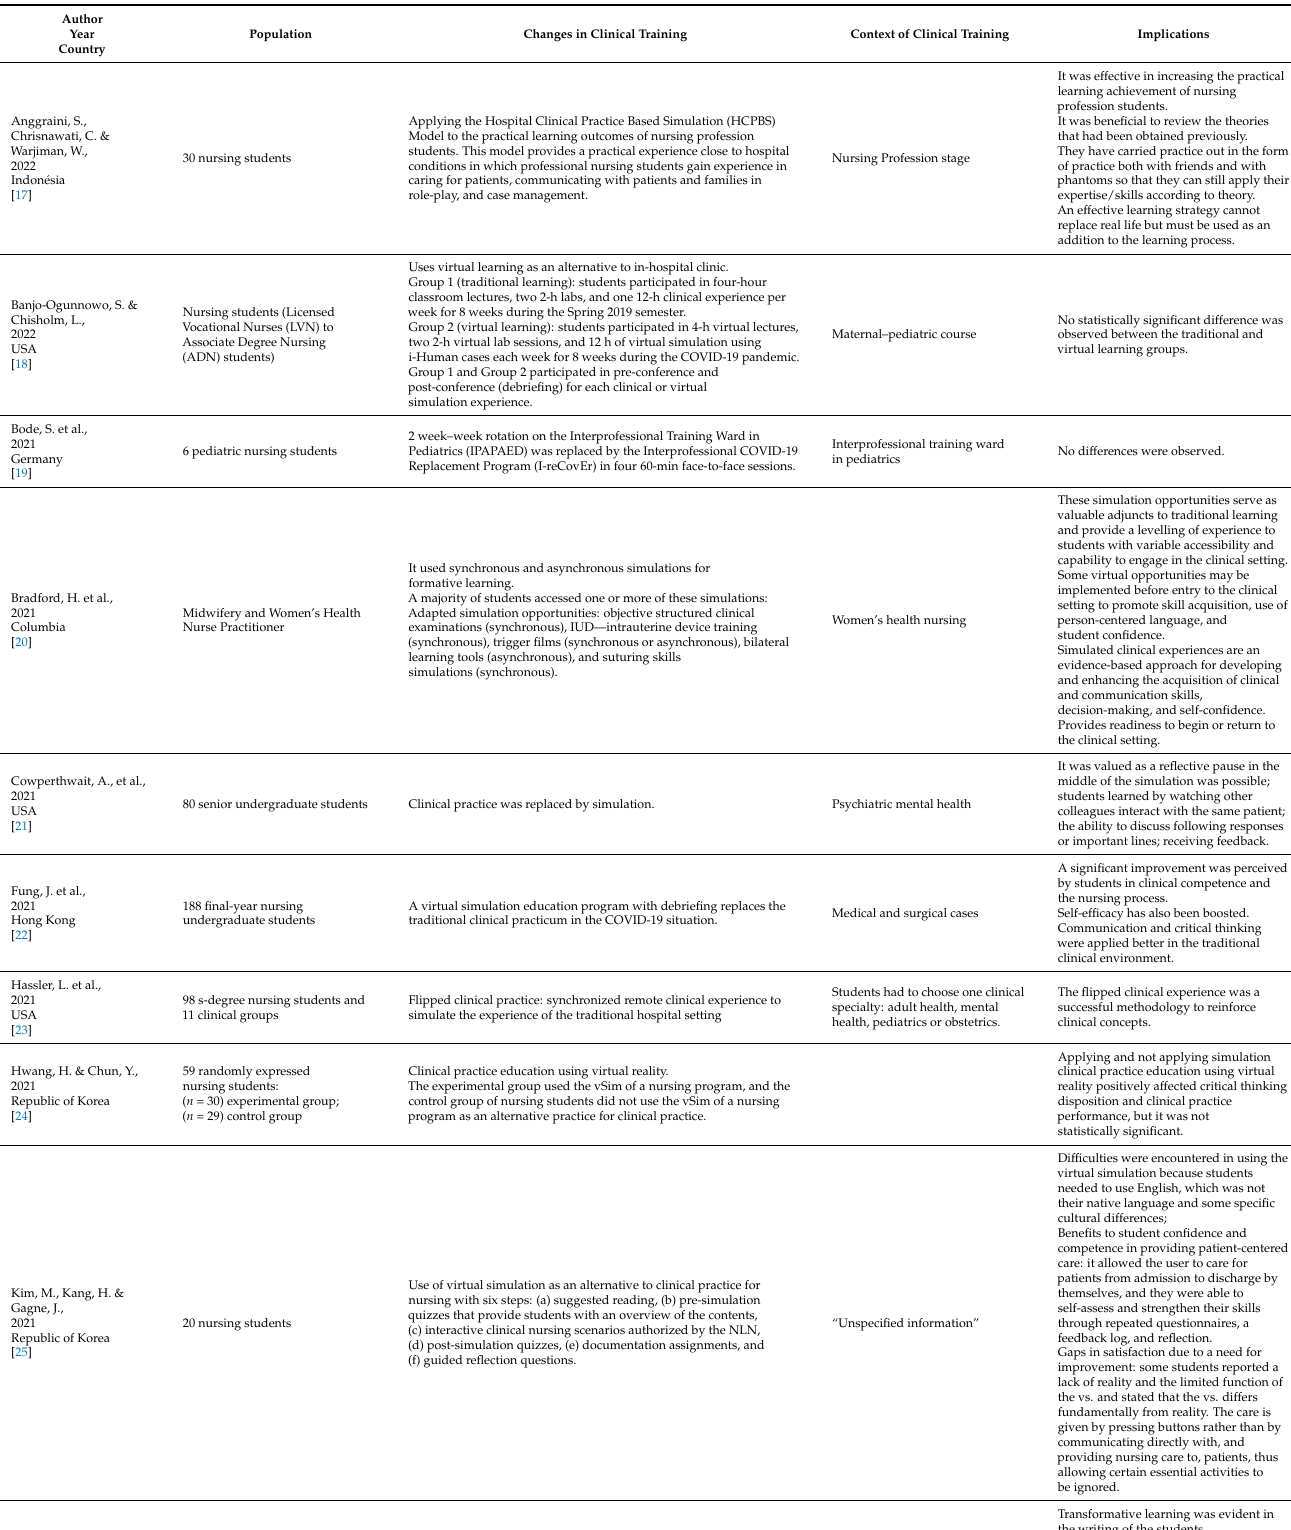
Table 2. Articles included in the scoping